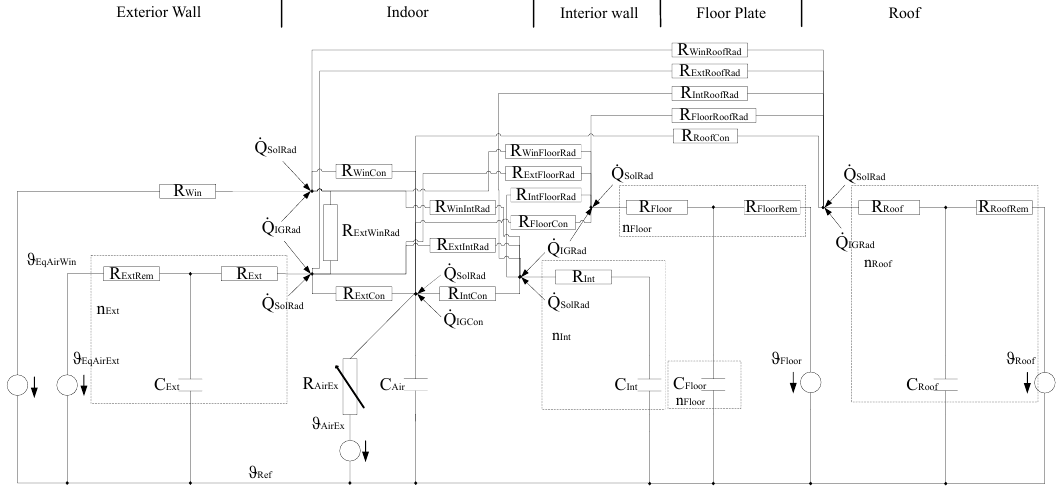
Figure 4. Four elements building model generated by TEASER [43].